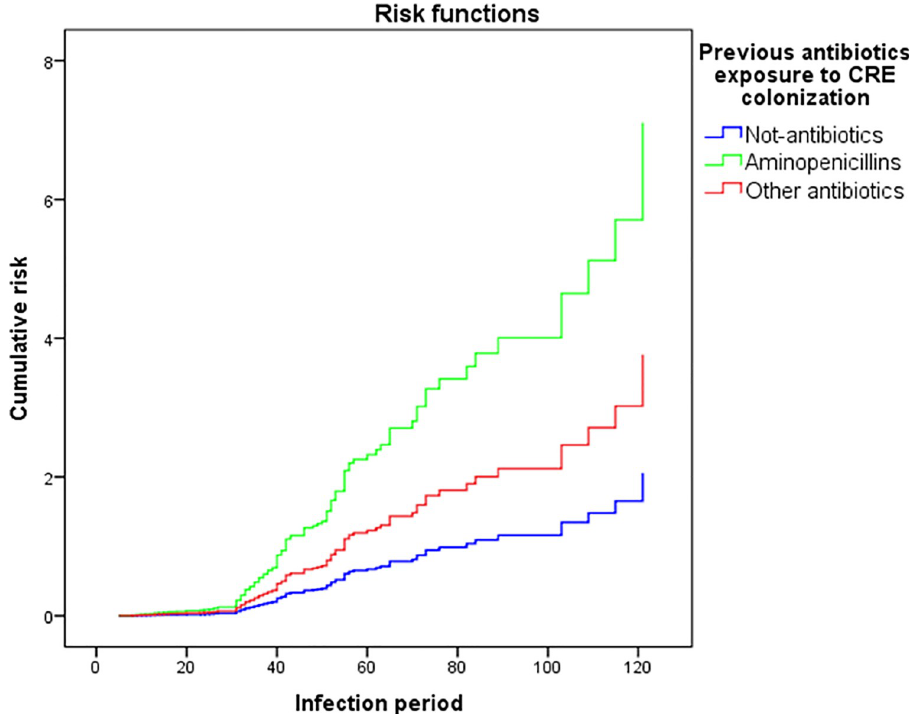
Fig 3. Multiple Cox regression analysis of the risk estimation for previous antibiotics exposure in CRE-colonized patients compared with controls.